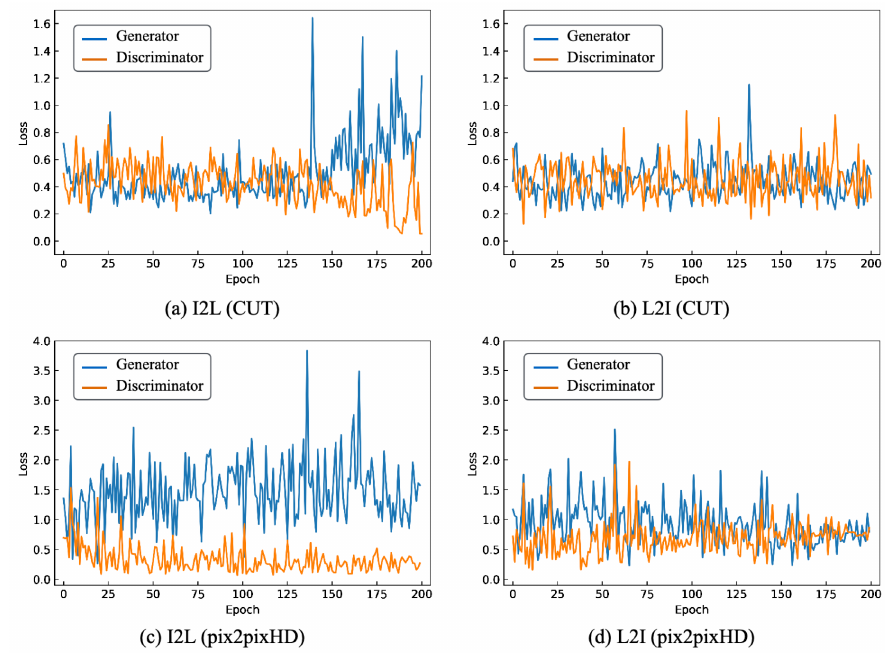
Figure 6. Time-series training loss trends for the respective GANs in